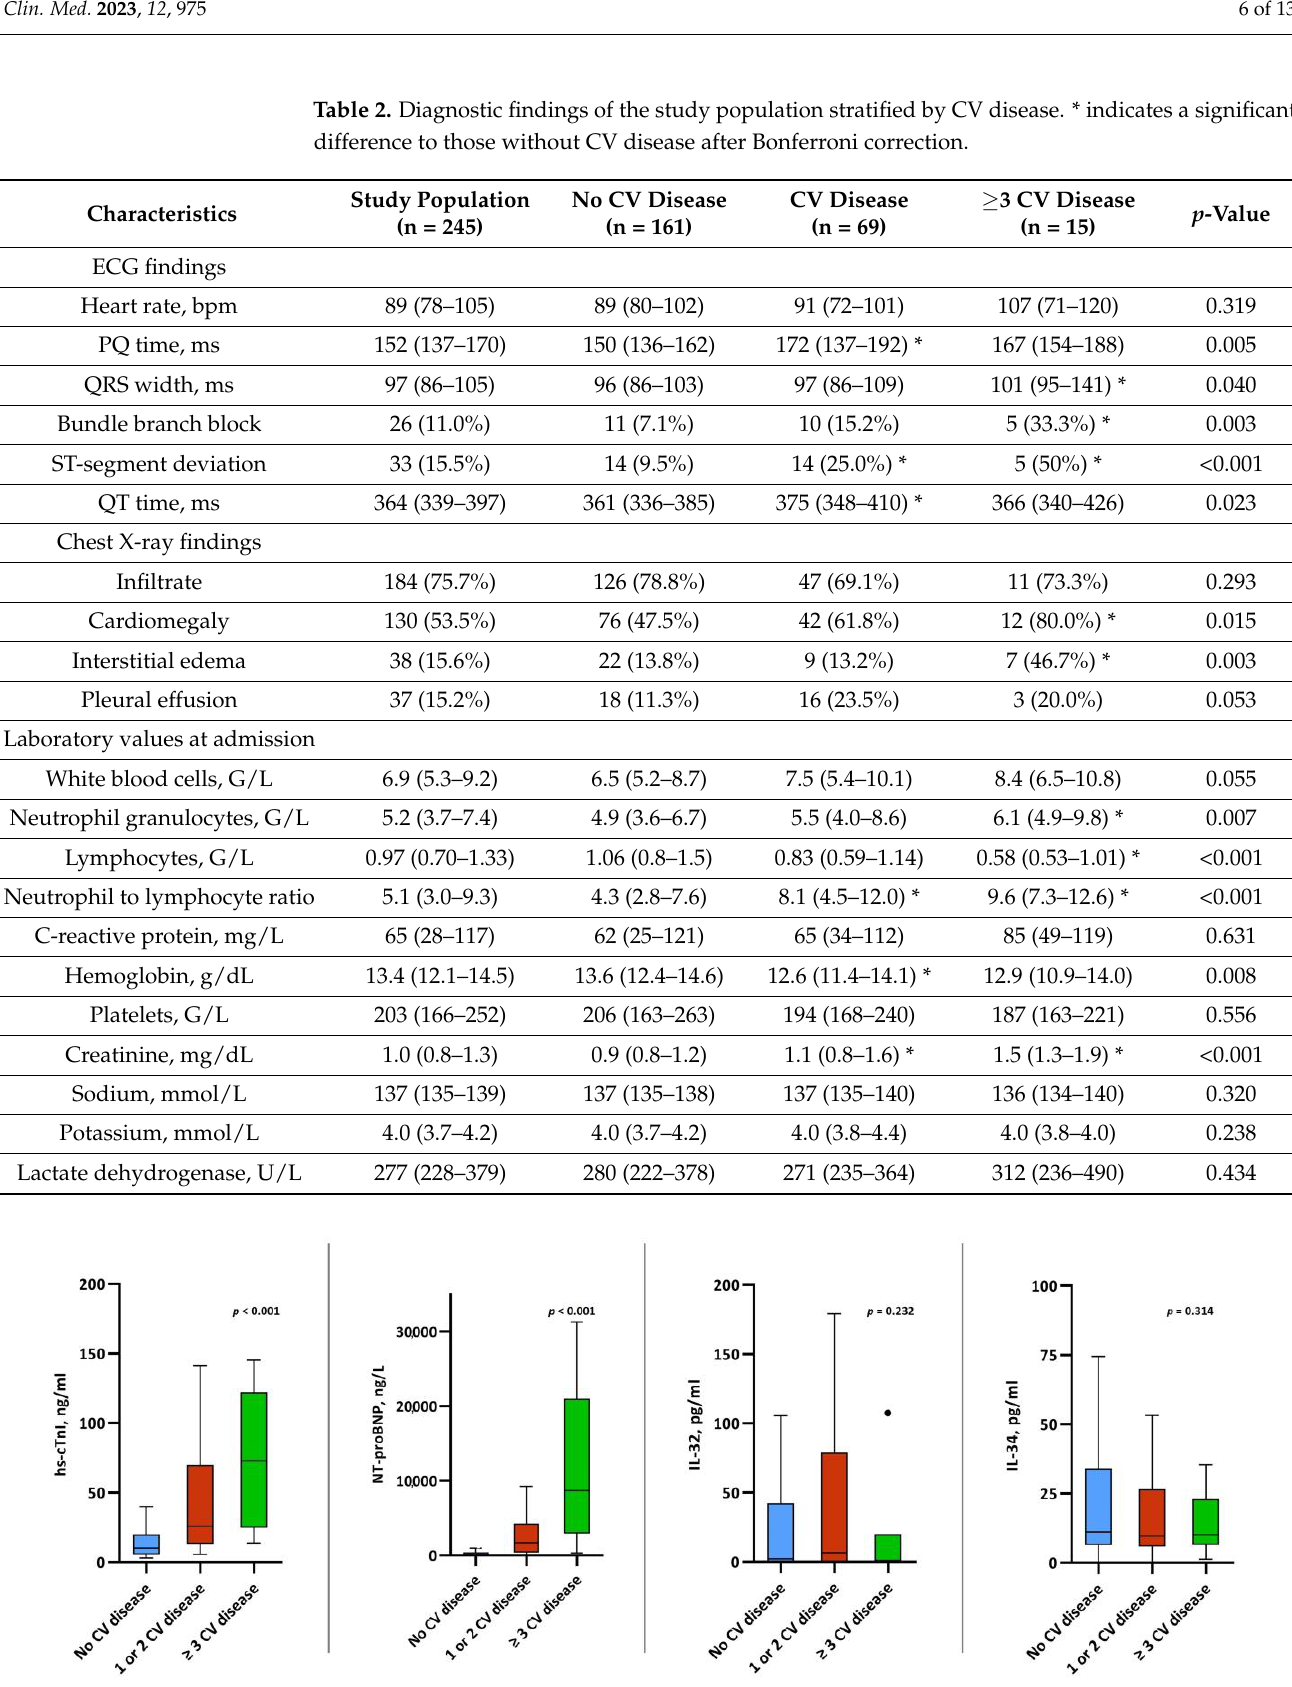
Figure 2. Box plots of IL-32, IL-34, hs-cTnI and NT-proBNP levels stratified by CV disease. Table 3. Correlation of IL-32 and IL-34 with CV and inflammatory biomarkers.